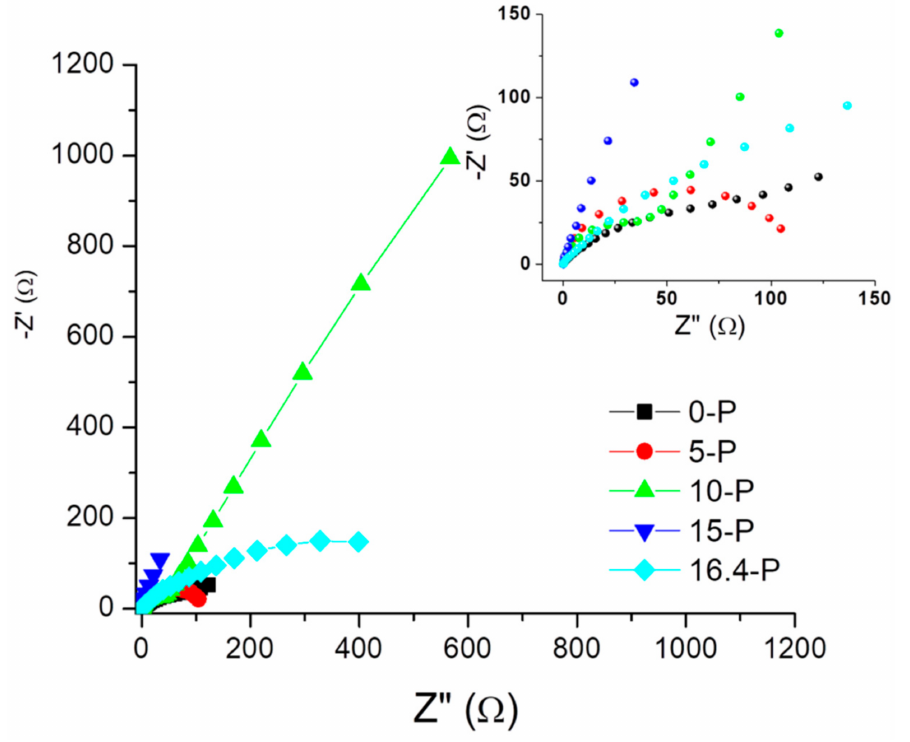
Figure 3. The Nyquist diagram of the EIS for the five alloy samples.